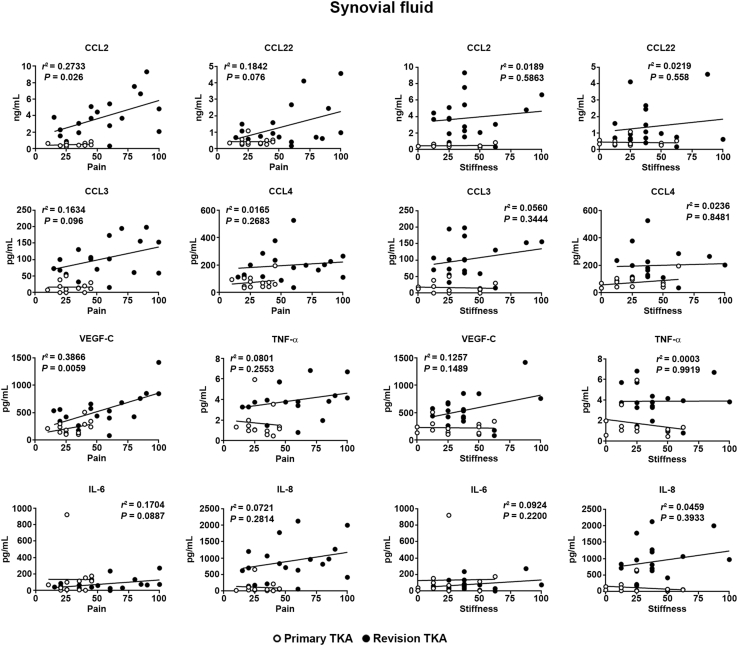
Pain positively correlates with levels of CCL2 in synovial fluid. Pain and stiffness, as determined by Western Ontario and McMaster Universities Osteoarthritis Index scores, were plotted against expression levels of several markers that were significantly elevated in the synovial fluid of patients undergoing revision total knee arthroplasty (TKA). Data are presented for patients undergoing primary and revision TKA, and correlations were determined by linear regression analysis. Increased levels of CCL2 are highly predictive of pain but are poorly correlated to stiffness. n = 13 primary TKA group; n = 18 revision TKA group. TNF, tumor necrosis factor; VEGF, vascular endothelial growth factor.